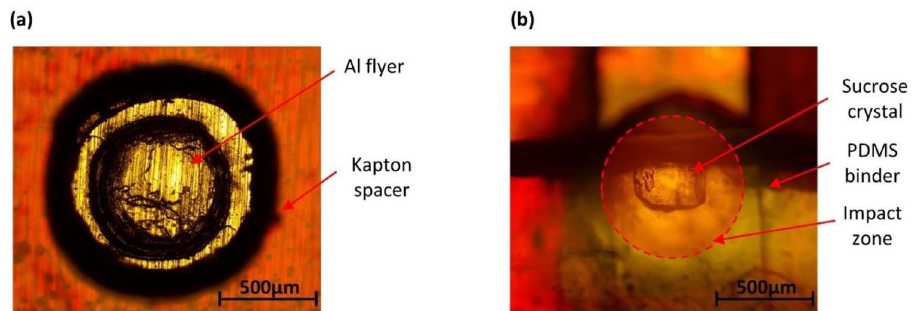
Figure 7. Preparation of launchpad for shock compression experiments where ( a ) Aluminum flyer enclosed by 300 µm Kapton spacer is used for impacts and ( b ) assembled with the target as sucrose crystal overlayed on the impact zone.